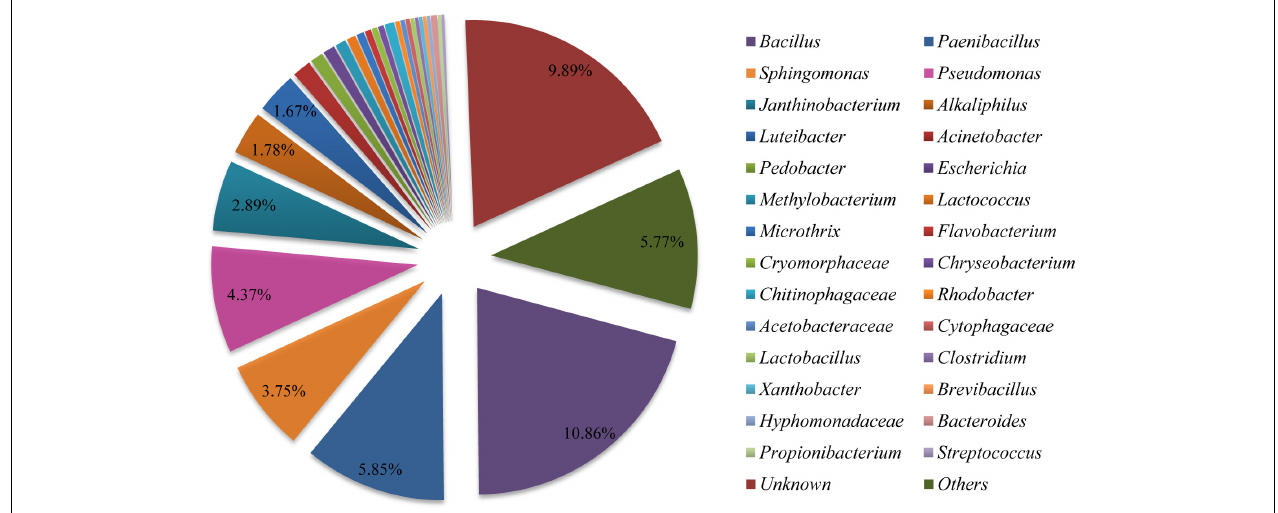
FIGURE 4 | Relative distribution of the bacterial genera in Shiraia fruiting body. Sequences are binned at the genus level and the abundance values are depicted as the percentage of the total bacterial sequences in a